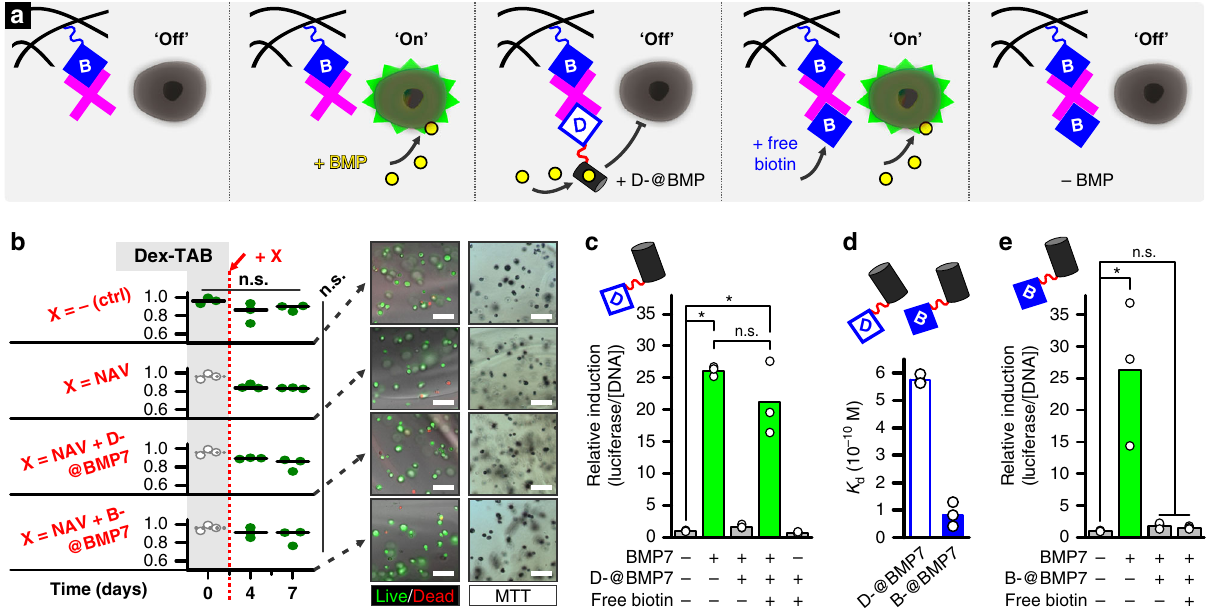
Fig. 5 Temporally controlling cell behavior using on-demand supramolecular displacement. a Dex-TAB was reversibly functionalized with BMP7-binding desthiobiotinylated V H H (D-@BMP7) to demonstrate the temporally controlled sequestration of BMP7 as visualized using BMP reporter cells. b Encapsulating cells in Dex-TAB did not signi fi cantly affect cell viability (i.e., live/dead) on the short-term (0 days) and long-term (7 days). Furthermore, cell viability and metabolic activity (i.e., MTT) were not signi fi cantly affected by the post-modi fi cation of Dex-TAB with neutravidin, D-@BMP7, and B-@BMP7. “ n.s. ” indicates no signi fi cance ( p > 0.1; Kruskal-Wallis ANOVA test). c Bioluminescence analysis of the BMP reporter cells con fi rmed the reversible biotin. “ n.s. ” indicates no signi fi cance ( p > 0.1). Asterisk indicates signi fi cance ( p < 0.05; Kruskal-Wallis ANOVA test). d Due to its stronger af fi nity